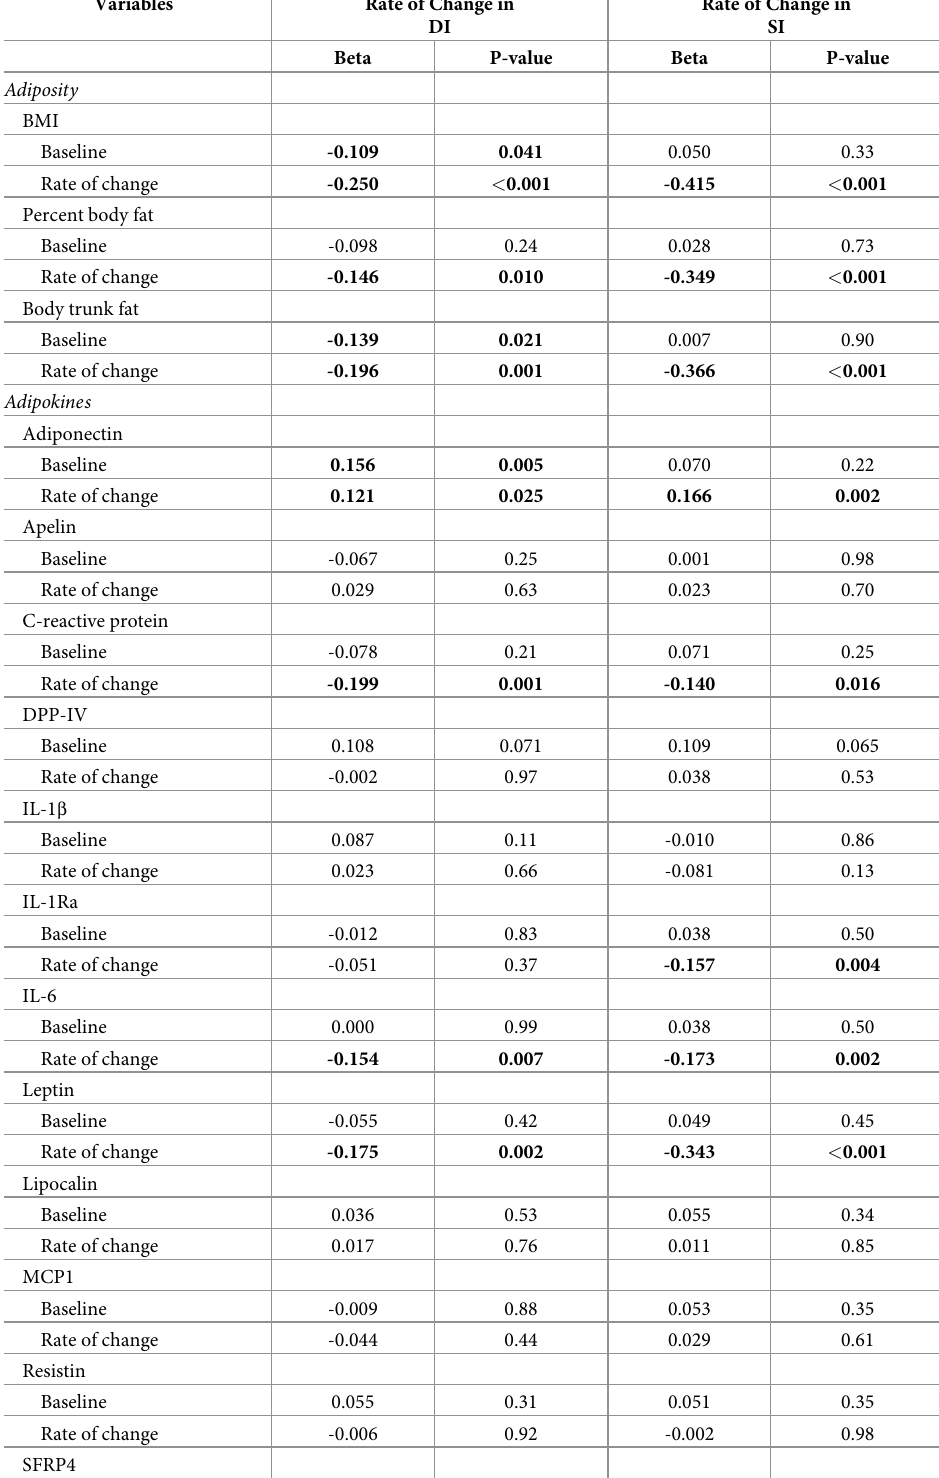
Table 3. Bivariate associations between rate of change in disposition index (DI) and insulin sensitivity (SI) with each of the adiposity or adipokine measures (cid:3)